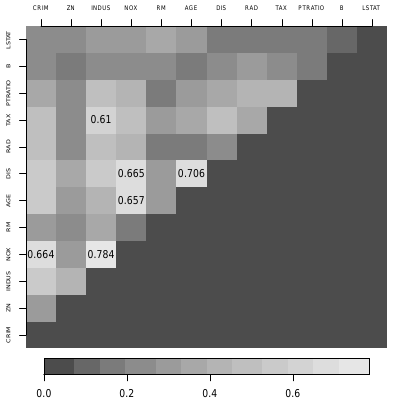
Figure 2 { Maximal local correlation statistics, Boston Housing complete